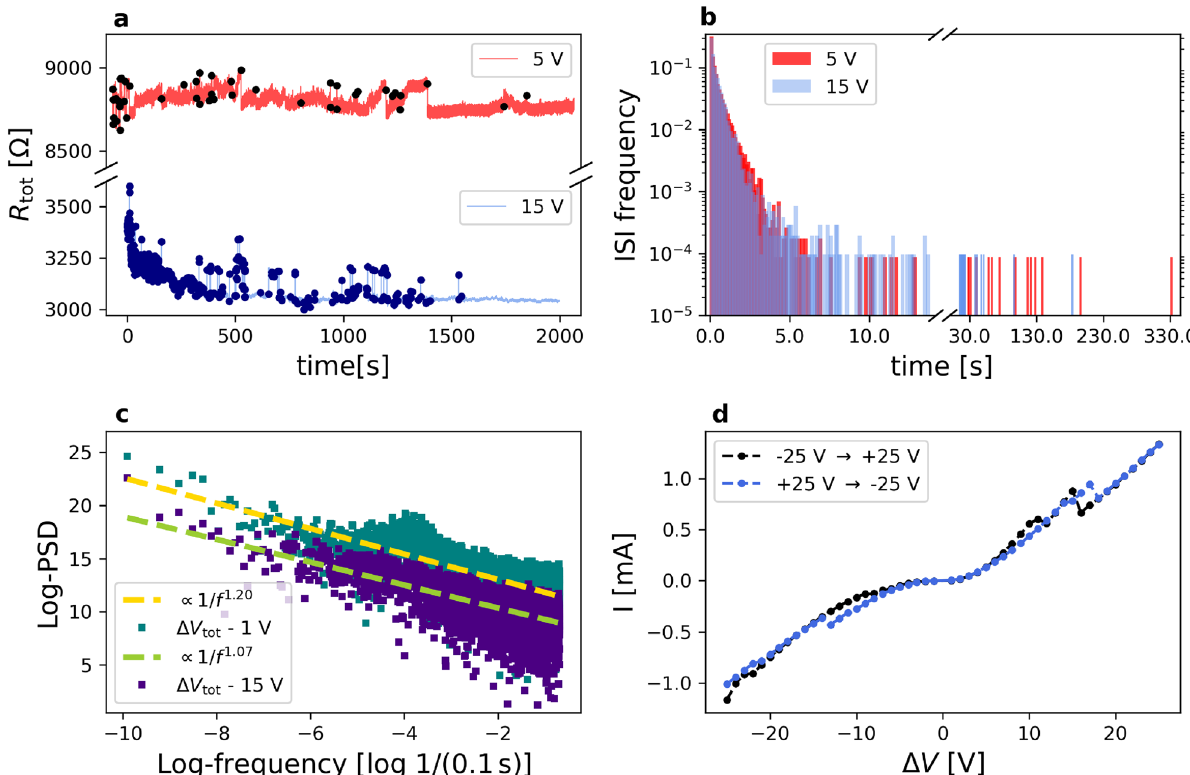
Figure 1. ( a ) typical evolution of electrical resistance with time under the application of (cid:31) V = 5 V (red) or 15 V (lavender), measurements are taken every 100 ms. Black and dark blue dots correspond to resistance switches. ( b ) Inter-Switch-Interval probability density, plotted collecting the temporal distance t ie = t i + 1 − t i (the inter- event time) of consecutive switches. ( c ) Experimental PSD for measurements taken at 1 V (blue-blue) and at 15 V (dark purple), as a function of frequency f , in log-log scale. Yellow and blue dashed lines represent 1 / f α fitted curves. ( d ) apparently nonlinear I (� V ) curve, from -25 V to +25 V, with discrete jumps equal to 1